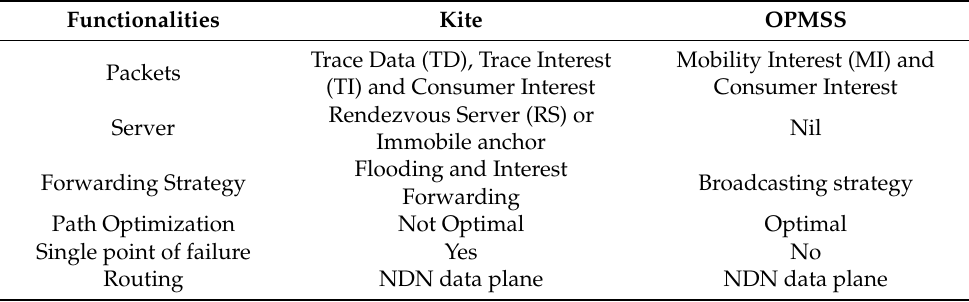
Table 3. Numerical Analysis Parameters and